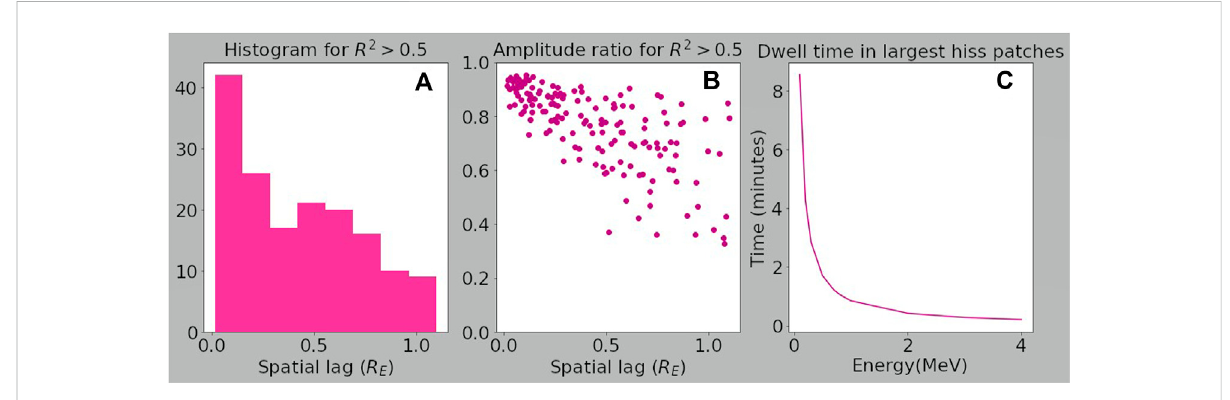
FIGURE 8 (A) Histogram of spatial lags between spacecraft that yield correlations with R 2 > 0.5 for whistler-mode wave power. (B) Amplitude ratio of whistler-mode waves measured by each spacecraft for spatial lags shown in histogram. (C) Estimated dwell time in largest observed whistler-mode wave patches as a function of energy. Subset of correlation data where Van Allen Probes A and B both have L * < 4 taken from Zhang et al.